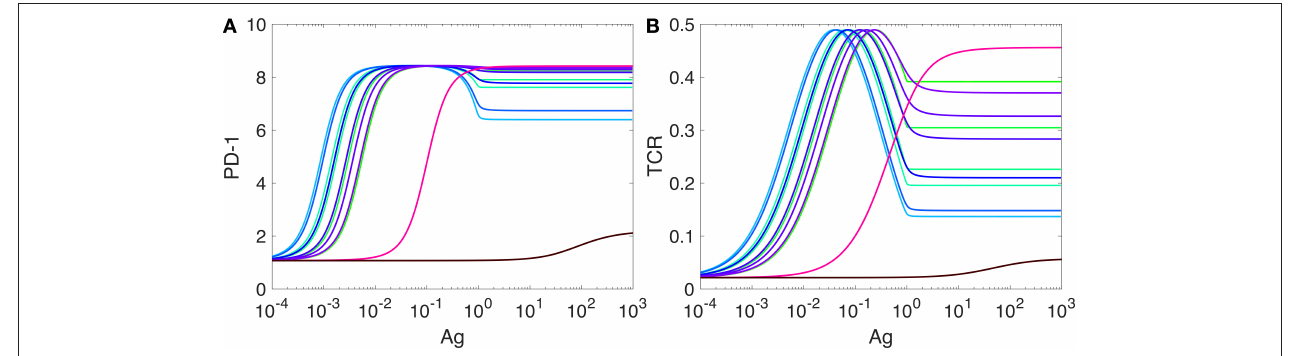
FIGURE 6 | Expression of PD-1 in the case when the expression of IRF4 is disabled. The levlel of PD-1 receptors in (A) is computed from our model developed in SI2. The level of TCR activity in (B) is computed from the model developed in Lever et al. (74) as explained in SI-2. All other explanations and parameter values are as in Figure 5